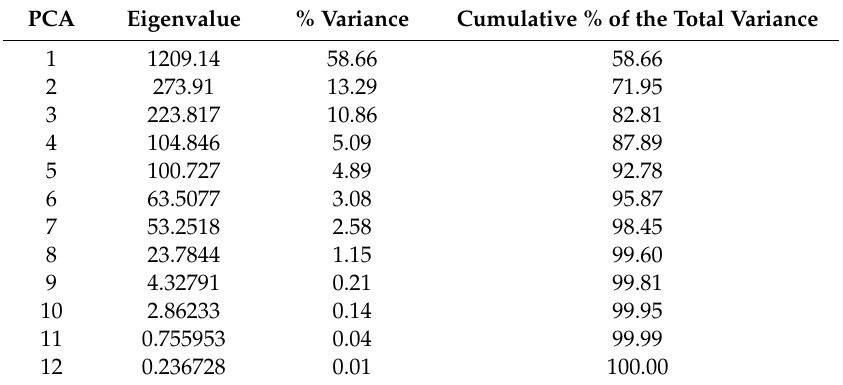
Table 3. PCA factors based on pteropods and their percentages of the total variability for core KIM-2A.